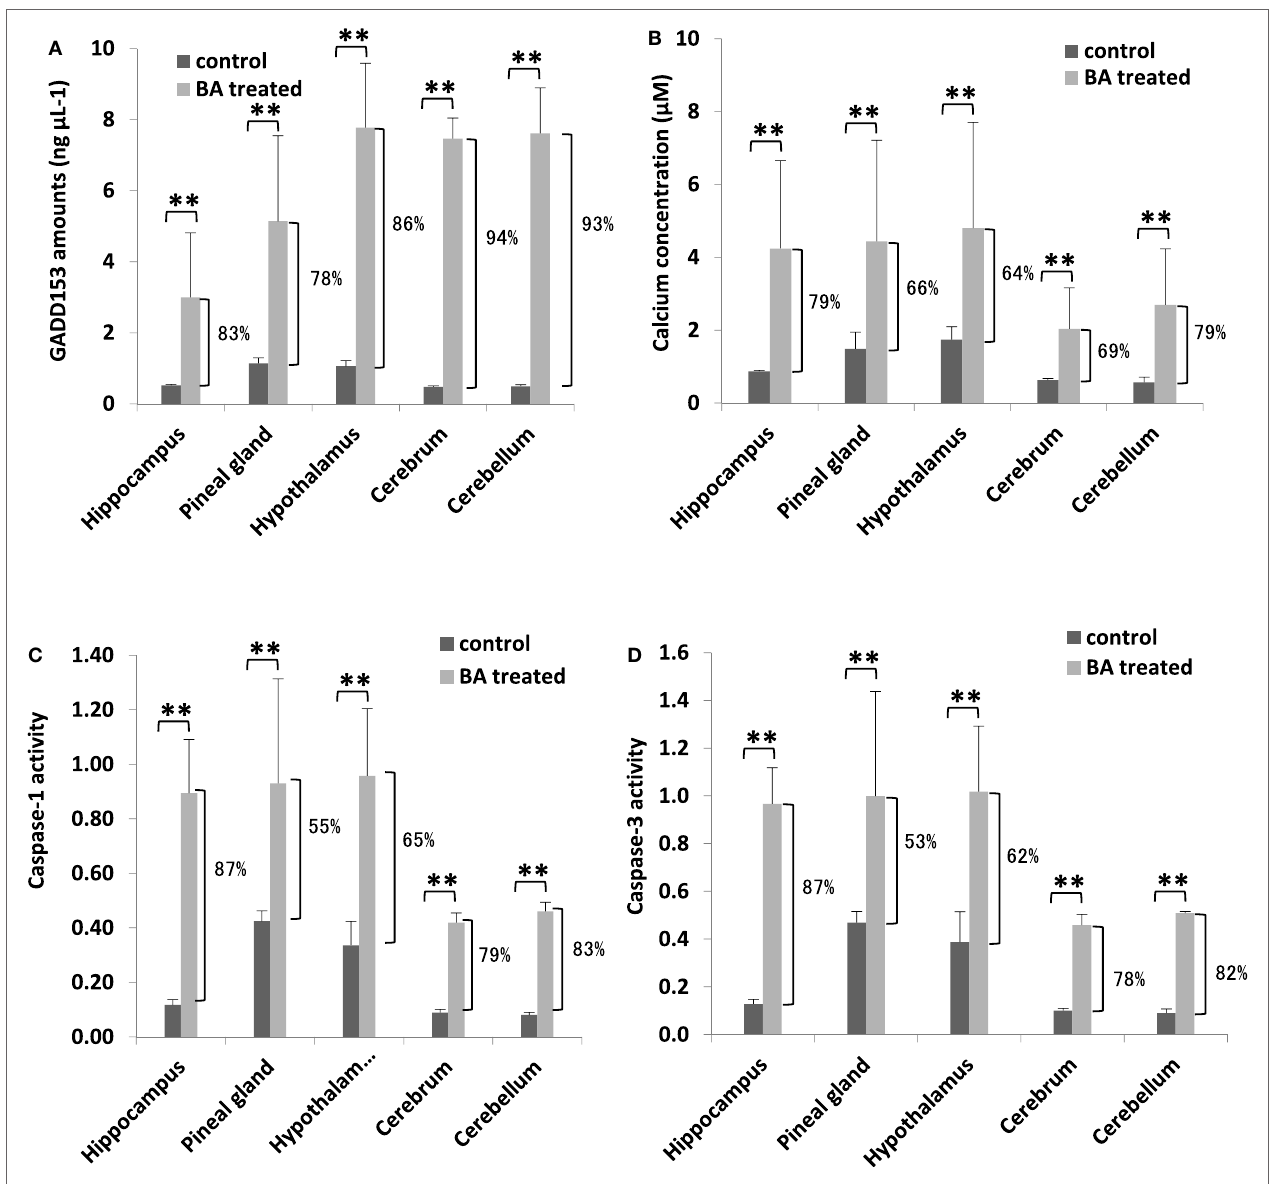
FigUre 5 | Endoplasmic reticulum stress stimulation and cell death activation in the different brain regions are ascribable to gingival periodontal disease level- butyric acid (BA). Quantification of brain (a) GADD153 amounts, (B) calcium concentration, (c) caspase-1 activity, and (D) caspase-3 activity are indicated. Results shown are mean ± SE utilizing independent brain samples (hippocampus, pineal gland, hypothalamus, cerebrum, and cerebellum) of 10-week-old Wistar male rats ( n = 6). Control and BA-treated (12 h post-treatment) rats were used. Statistical analyses were performed using Anderson–Darling normality test and, if passed ( p > 0.05), Student’s t -test (** p < 0.01). Percent difference between control and BA-treated rats are